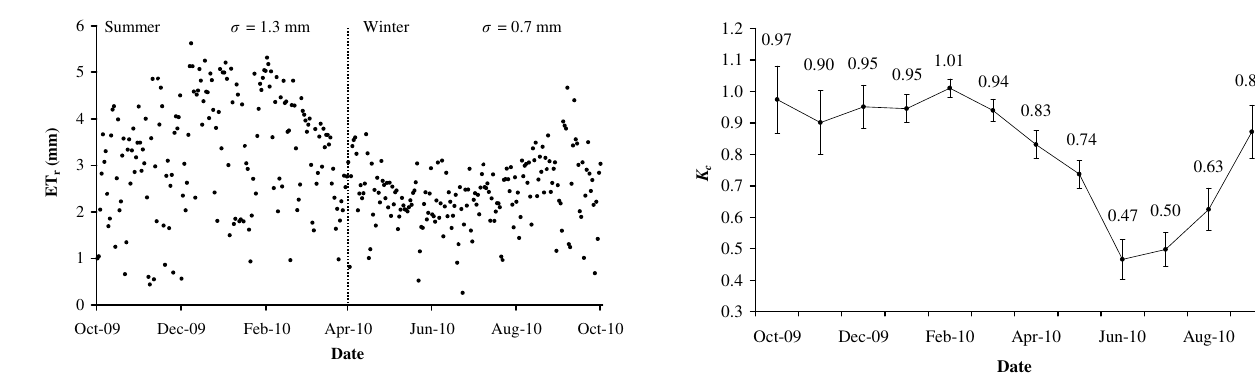
Fig. 9. Mean monthly crop factor ( K c ) for the Mfabeni Mire from October 2009 to September 2010 with 95% confidence